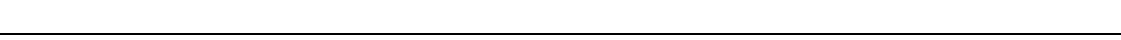
Fig. 4 De novo DNA methylation during B cell differentiation. a Heat map of DNA methylation (DNAme) in lymph node B220 + GL7 − Fas − naive B cells (nB), B220 + PE + GL7 + Fas + germinal center B cells (GCB), and CD138 + bone marrow plasma cells (BMPC) in Dnmt3-suf fi cient ( Dnmt3a fl / fl Dnmt3b fl / fl ; C) and -de fi cient ( Cd19 cre/ + Dnmt3a fl / fl Dnmt3b fl / fl ; KO) mice (left) and average DNA methylation (right). b Principle components analysis of DNAme. The percentage in parenthesis is the proportion of variation explained by each component. c Number of differentially methylated loci (DML) between nB, GC, and BMPC cell types. d Heat map of all DML identi fi ed in c . e Analysis of motifs enriched within 50 bp of DML. The false discovery rate (FDR) signi fi cance is denoted by color (key right) and a full list can be found in Supplementary Data 6. f Plot of DNA methylation levels proximal to all genomic binding motifs for the indicated factors. g Number of DML between Dnmt3-de fi cient mice in nB, GCB, and BMPC relative to Dnmt3-suf fi cient cell types. h Heat map of loci identi fi ed in g . i Average DNA methylation for all loci determined in f . j Overlap of Dnmt3 DML with H3K4me1 + H3K27ac + enhancers in the designated cell types (light orange: nB; orange: GCB, brown: BMPC). k Examples of differentially methylated loci between Dnmt3-suf fi cient and Dnmt3-de fi cient cells. Scale is from 0 to 100% DNAme. ** P ≤ 0.01, *** P ≤ 0.001, Student's two-sided t- test. Data were derived from 3 experiments and 24 mice, where nB were isolated from 6 mice, GCB were from 12 mice (2 mice were pooled per sample), and BMPC were from 6 mice. Each cell type contained four female and two male (nB, GCB) or four male and two female (BMPC) mice split evenly between the